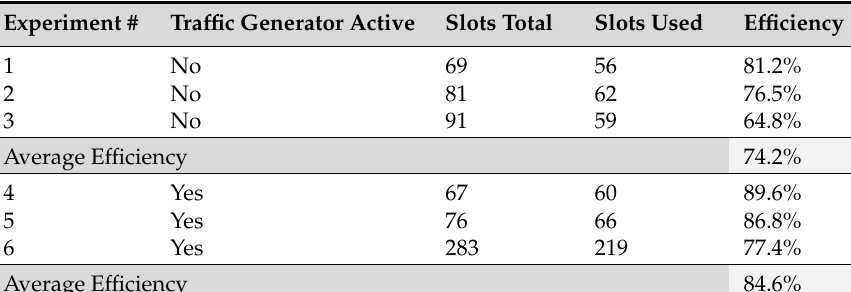
Table 4. Data from the base station